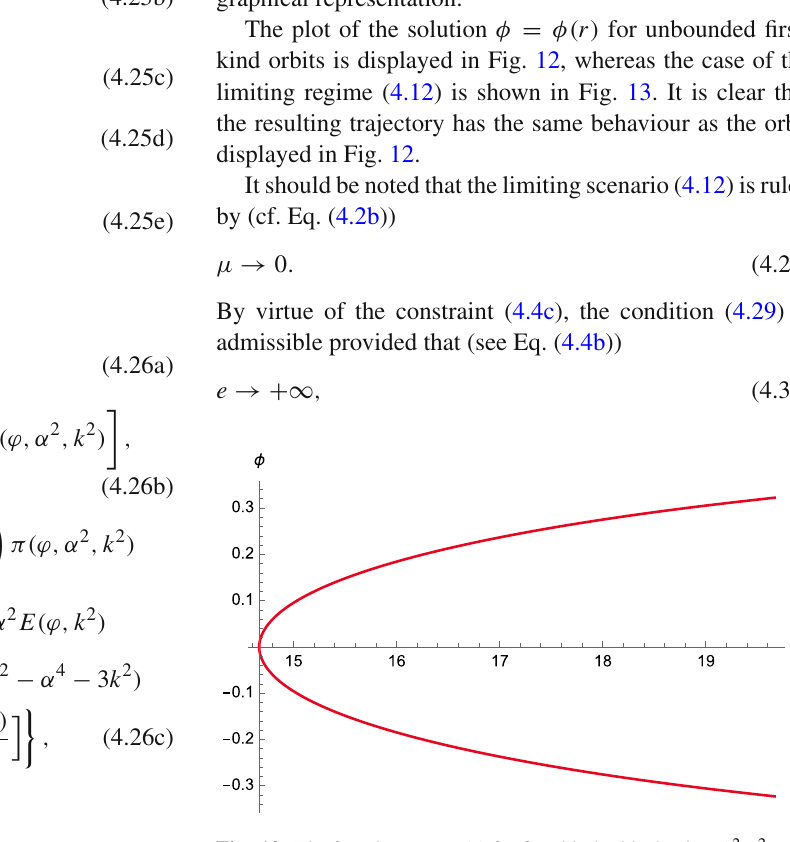
Fig. 12 The function φ = φ( r ) for first-kind orbits having C 2 E 2 <